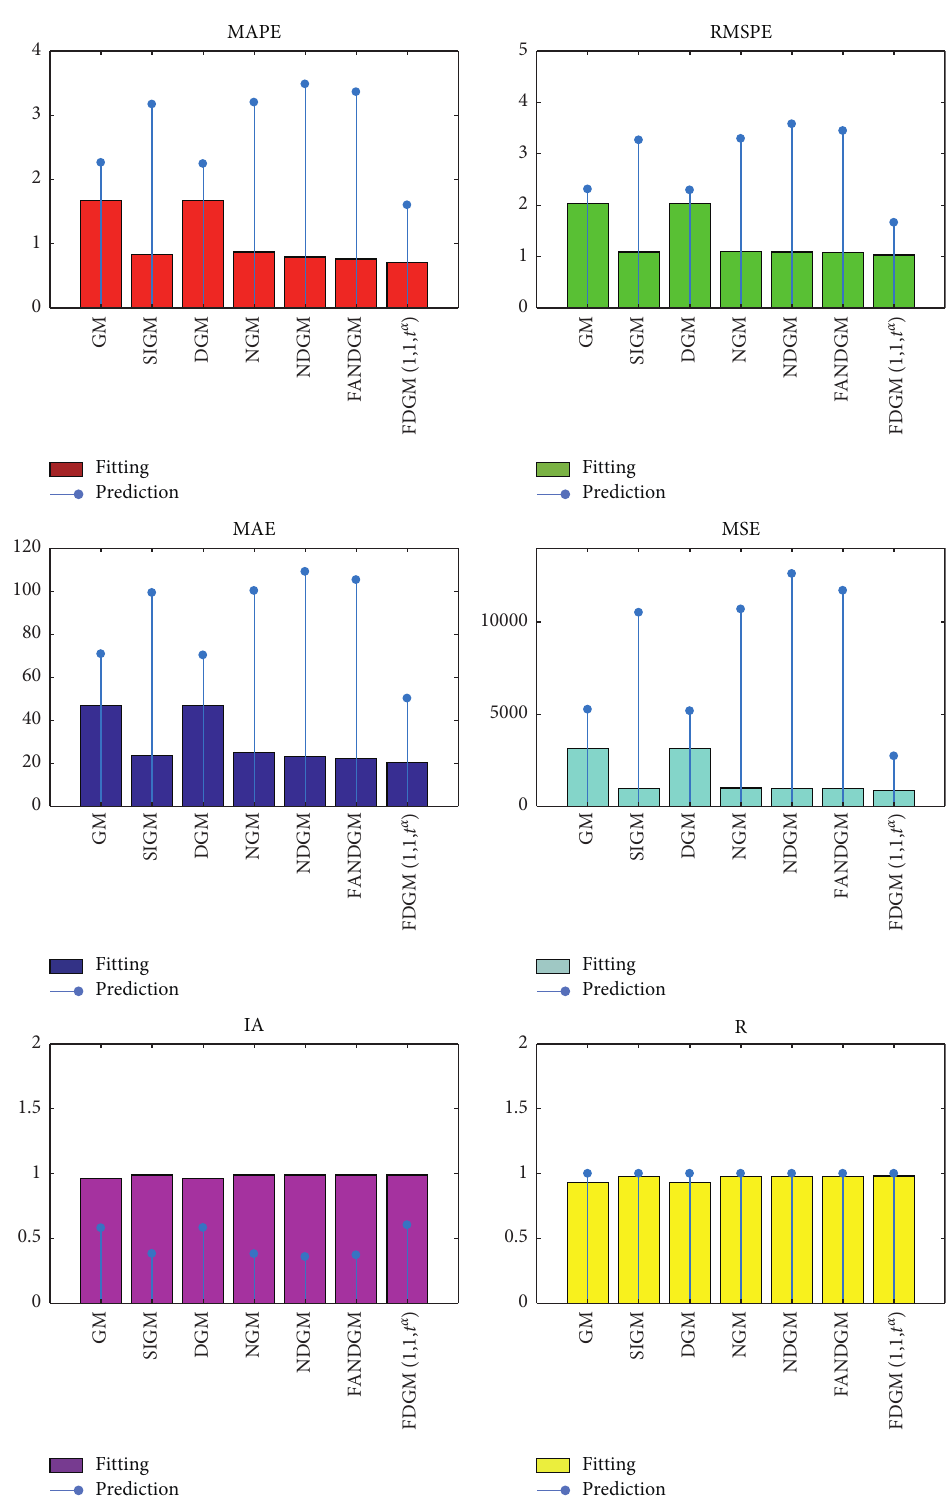
Figure 13: Error metrics of energy consumption of civil building in